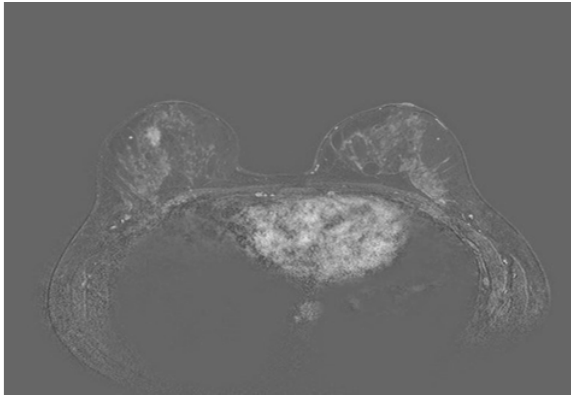
Figure 5: 40-year-old woman presenting for screening mammog- raphy and ultrasound. Mammography (not shown) revealed dense breasts and no focal lesions. Ultrasound showed a hypoechoic mass withangularmargins.Biopsyshowsstromalfibrosis.Follow-upafter two years showed no malignancy.